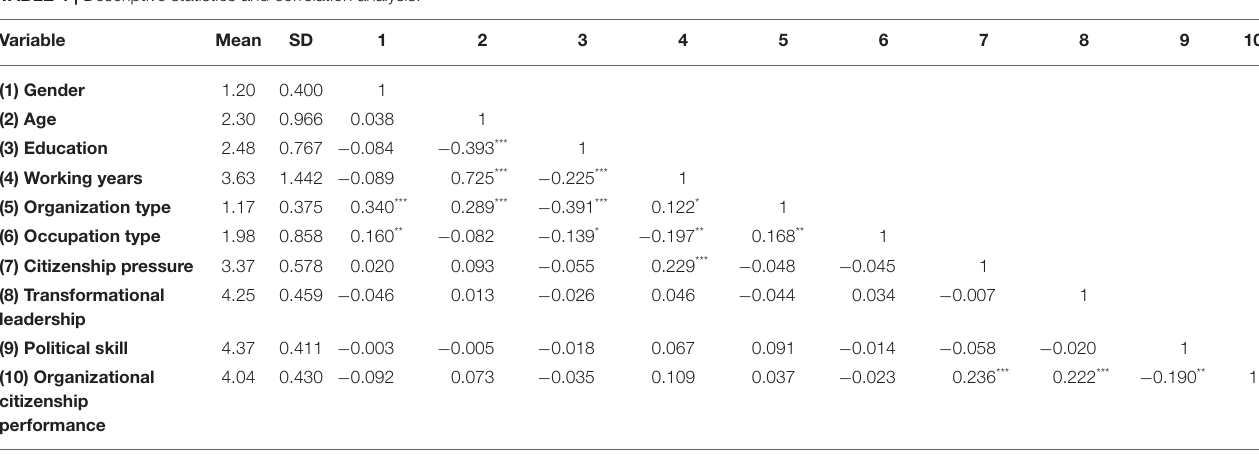
TABLE 4 | Descriptive statistics and correlation analysis.